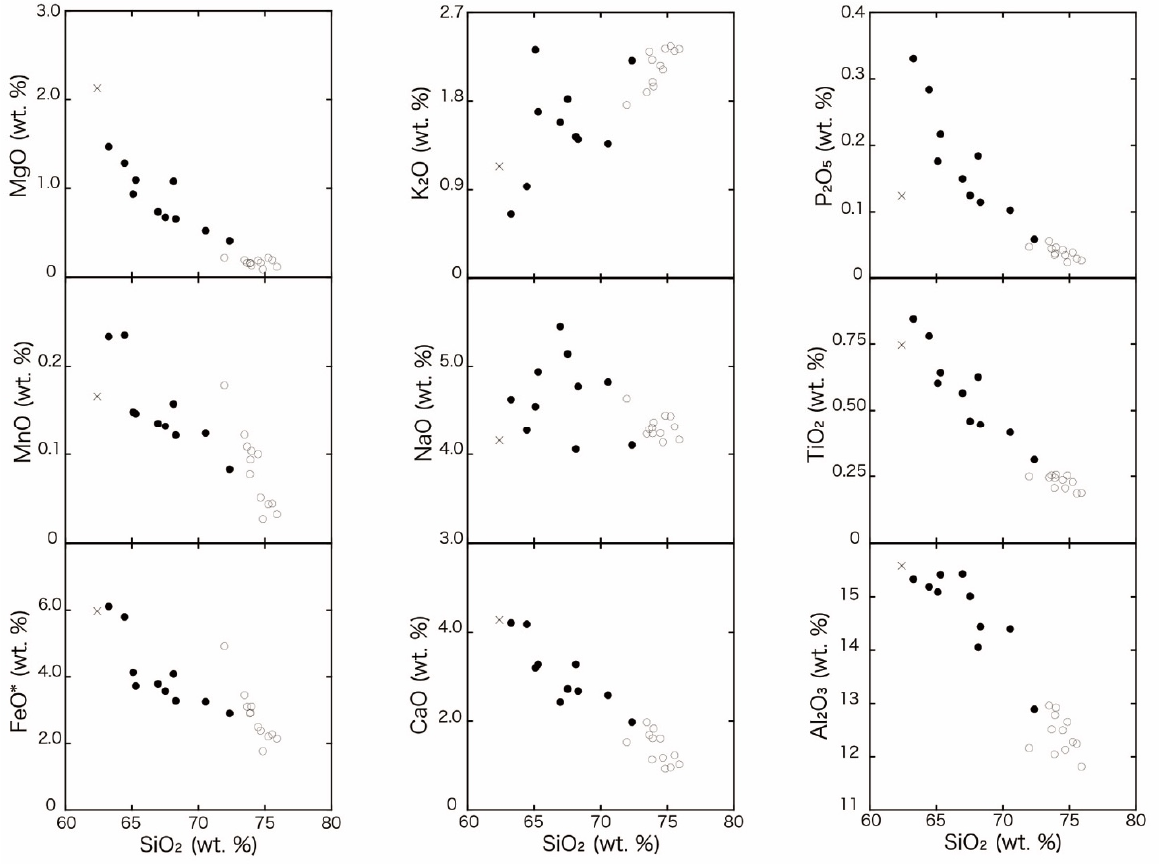
Figure 4. Harker diagrams for major elements. Solid circles—GD group samples. Open circles—HFG group samples.Cross mark—dike sample. Dike samples GTA-2b and GTB-5b fall outside the plotting range.